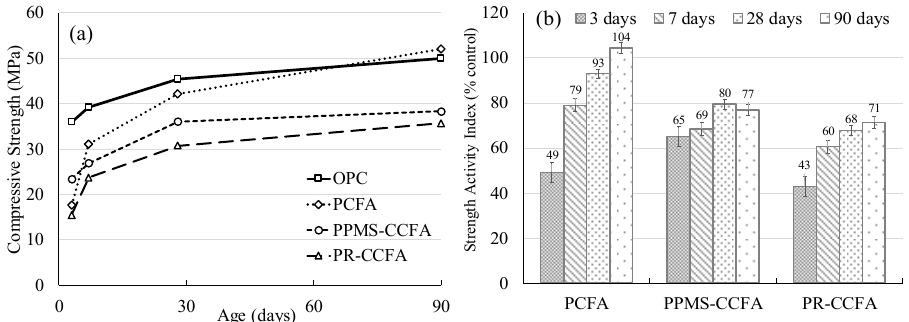
Figure 5. Strength development and strength activity index of different mortar mixtures ( a ) Compressive Strength, ( b ) Strength Activity Index.